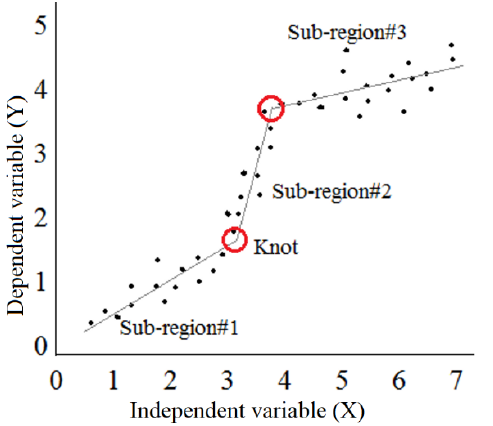
Figure 3. A schematic sketch for the illustration of sub-regions of the MARS